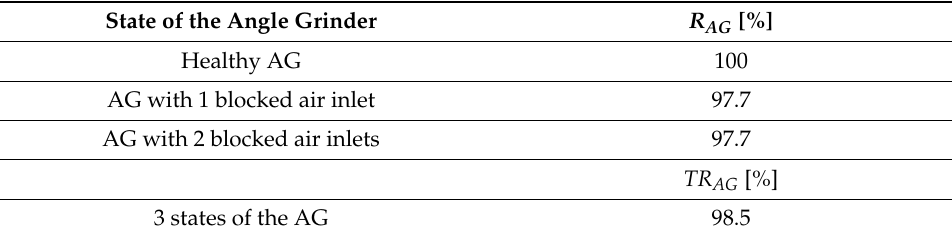
Table 6. Values of TR AG and R AG for using of BCAoMID − F, PCA, and SVM. State of the Angle